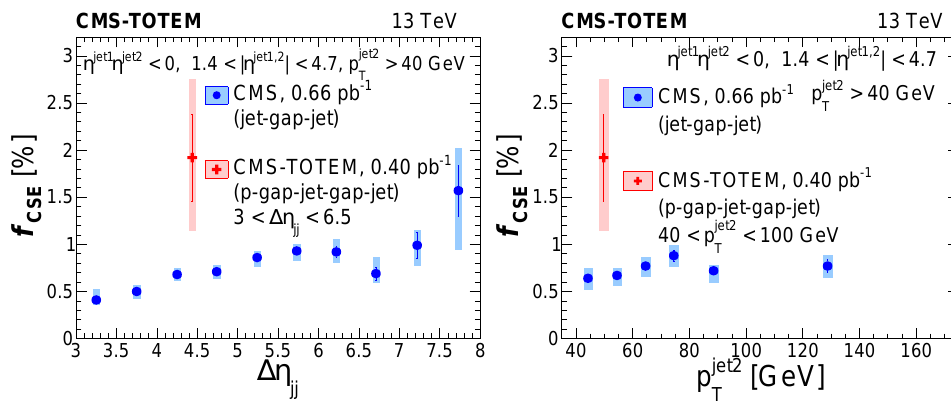
Figure 5: Fraction of hard color-singlet exchange dijet events f , measured as a CSE function of ∆ η (Left) and p jet2 (Right) extracted in inclusive dijet event production jj T (labeled CMS, represented by the blue circle markers) and in dijet events with an intact proton at 13 TeV (labeled CMS-TOTEM, represented by the red cross marker). The vertical bars represent the statistical uncertainties, and boxes represent the com- bination of statistical and systematic uncertainties in quadrature. The figure is ex- tracted from Ref. [ 1 ]